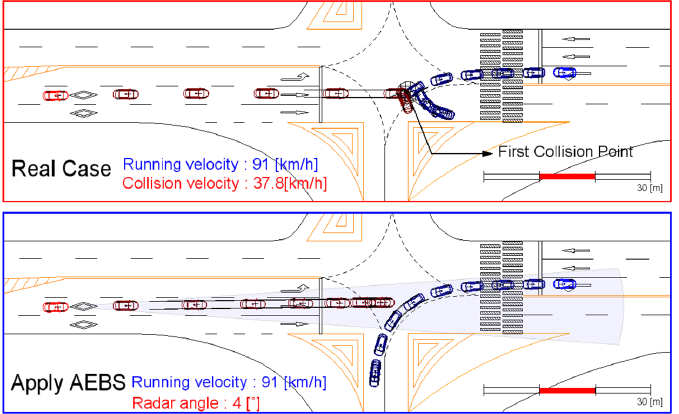
Figure 14. Real Case 2 application of the AEBS.